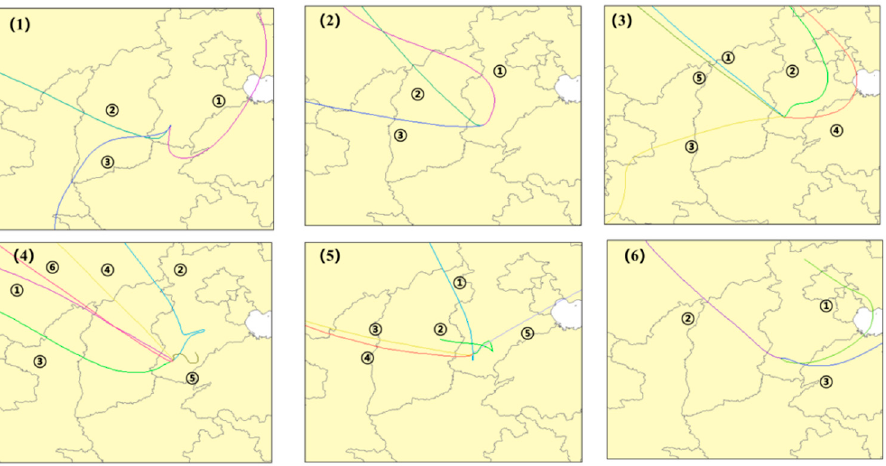
Figure 10. The clustering results of the six pollution processes, path 1, path 2, path 3 ( 1 , 2 , 6 ); path 1, path 2, path 3, path 4, path 5 ( 3 , 5 ); path 1, path 2, path 3, path 4, path 5, path 6 ( 4 ).